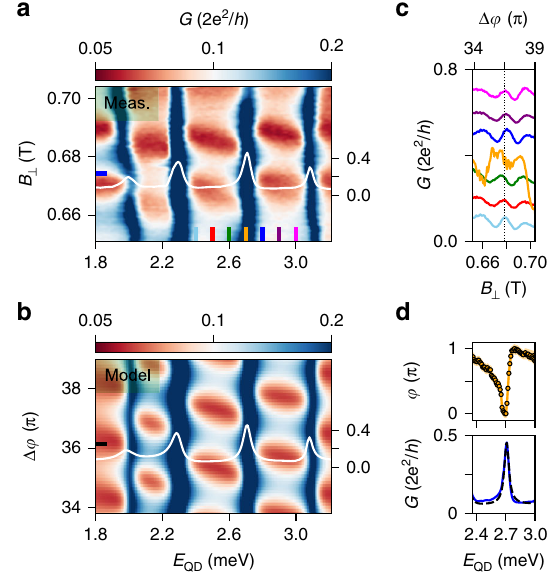
Fig. 5 Multi-path transport effects. a G vs. E QD and B ⊥ exhibiting the evolution of four CPs. Data are taken at back-gate voltage V BG = − 1.5 V. b Calculated conductance assuming a multi-path interferometer, details are reported in the "Methods". The white traces in ( a ) and ( b ) correspond to the values indicated by the horizontal lines, and the vertical axes refer to conductance G in 2 e 2 / h . c Vertical line-cuts of ( a ) showing the evolution of AB oscillations across a charge transition in the QD. Traces are displaced by 0.1 ⋅ 2 e 2 / h for clarity, except for the orange one taken on resonance. d Top panel: the trend of the AB maxima across the third CP. The shaded region indicates the error bars stemming from the uncertainty in extracting the oscillation maxima that is ~1 − 2 mT. Bottom panel: solid and dashed lines are horizontal line-cuts of ( a ) and ( b ), respectively, at the position indicated by the blue/black lines.